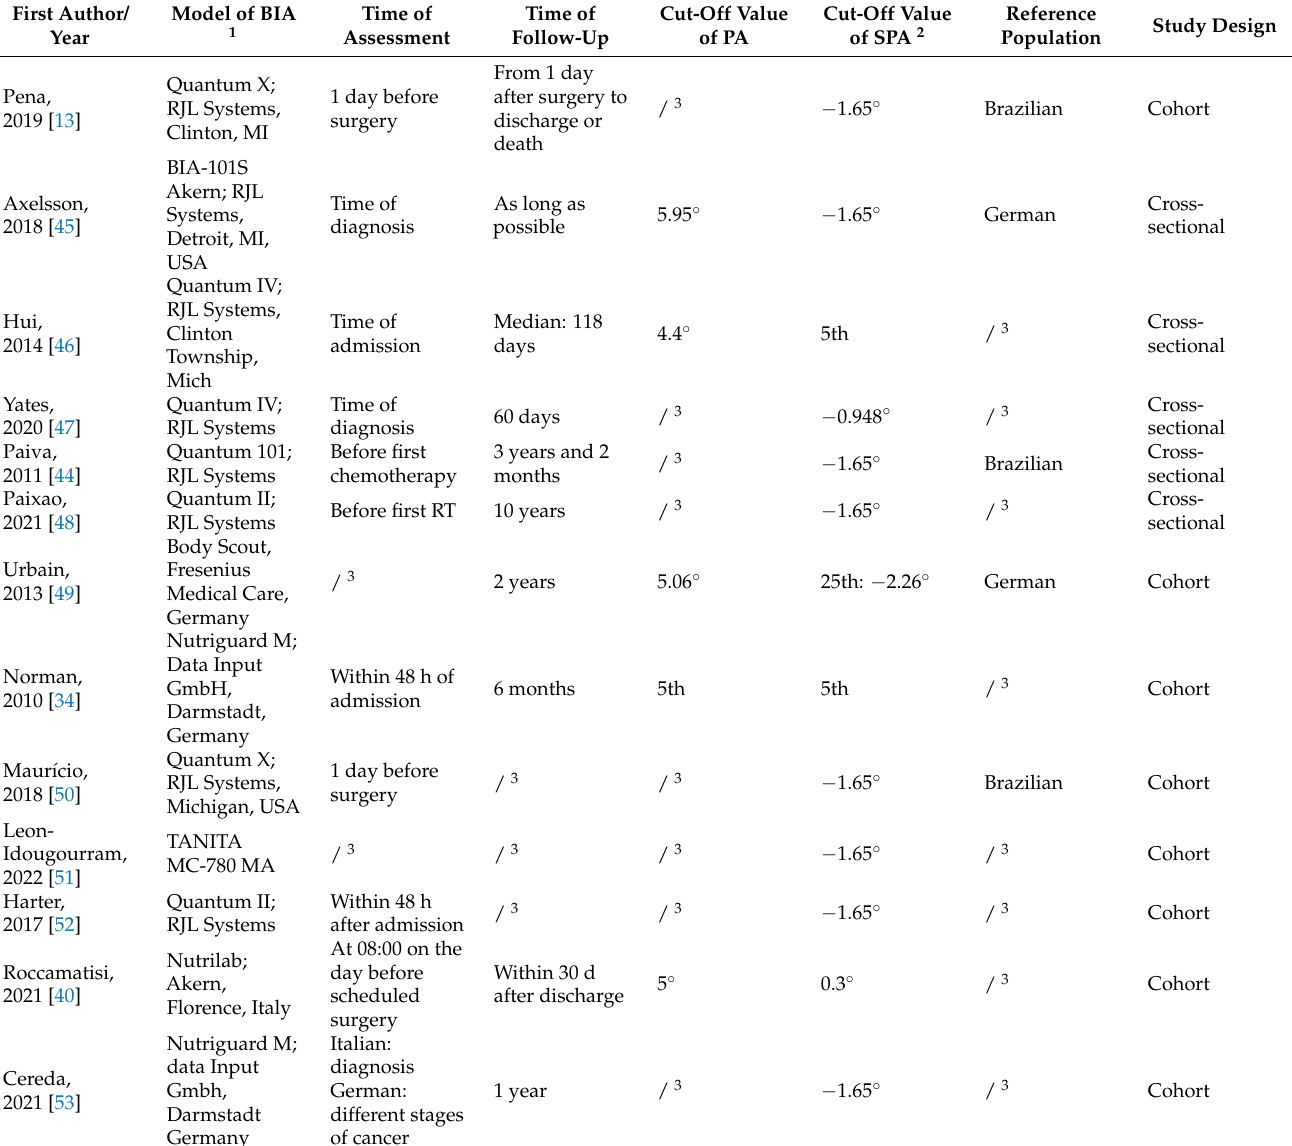
Table 3. Characteristics of included cancer